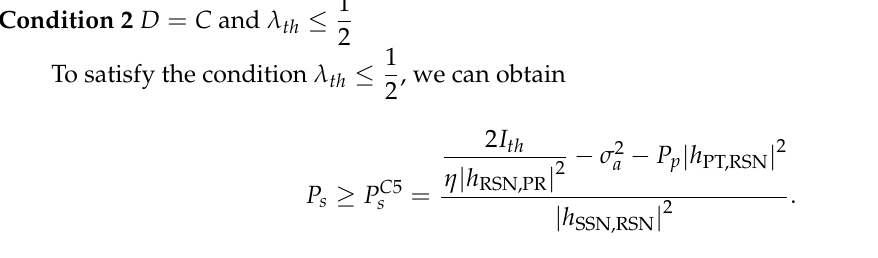
(cid:0) (cid:1) < P C 1 s , P C 3 s P 1 s . 1